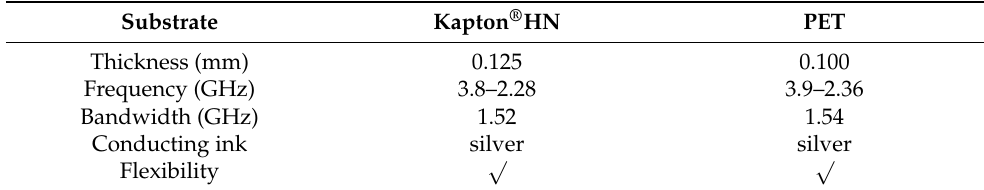
Figure 7. Reliability curve. Table 2. Comparison of substrates.